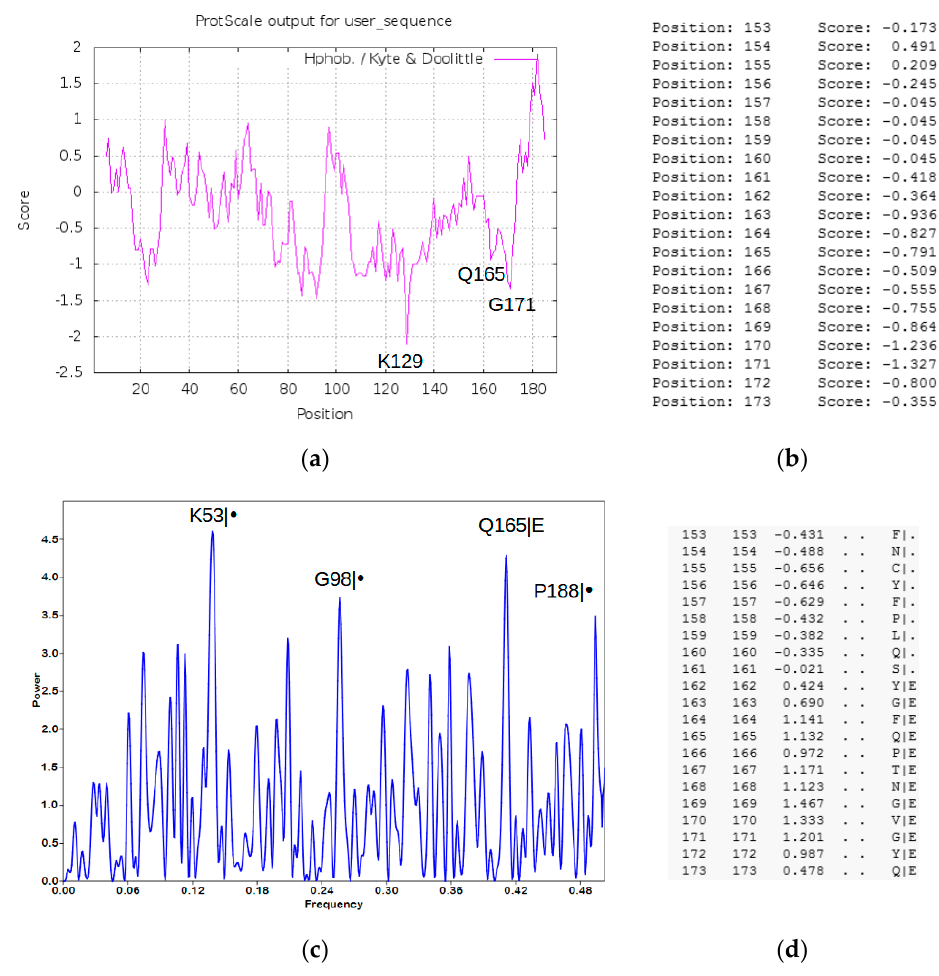
Figure 6. S1 epitopes of SARS-CoV-2 RBD sequence fragment (aa 334–523) were determined with Expasy—ProtScale tool using the hydrophobicity scale of Kyte & Doolittle and a sliding block of 11 amino acids [81,82] ( a ). Hydropathy scores for the epitope positions at aa 486–506 (153–173) ( b ). Informational Spectrum Method analysis based on the electron-ion interaction pseudopotential was used to determine the bioactive region (Q165) of the SARS-CoV-2 RBD sequence fragment (aa 334–523) [18,83,84] ( c ). Prediction of B cell epitopes of the SARS-CoV-2 RBD sequence fragment with BepiPred Server—positions aa 486–506 (153–173), E = part of a linear B cell epitope ( • represents a residue predicted not to be part of an epitope) [85] ( d ).